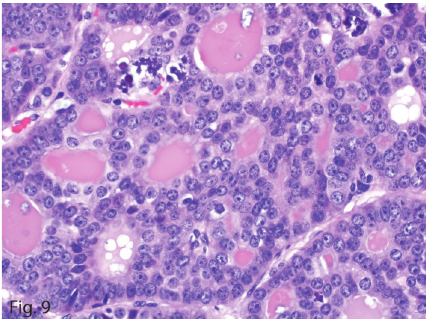
Figure 9: Metastatic hepatic neuroendocrine tumor in 2016 with morphologic characteristics similar to the previous hepatic tumors and an intermediate mitotic count (hematoxylin-eosin, original magnification × 40).